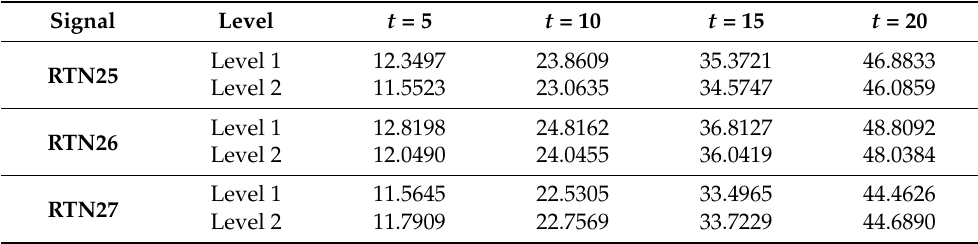
Table 3. Expected number of visits to each level for the different